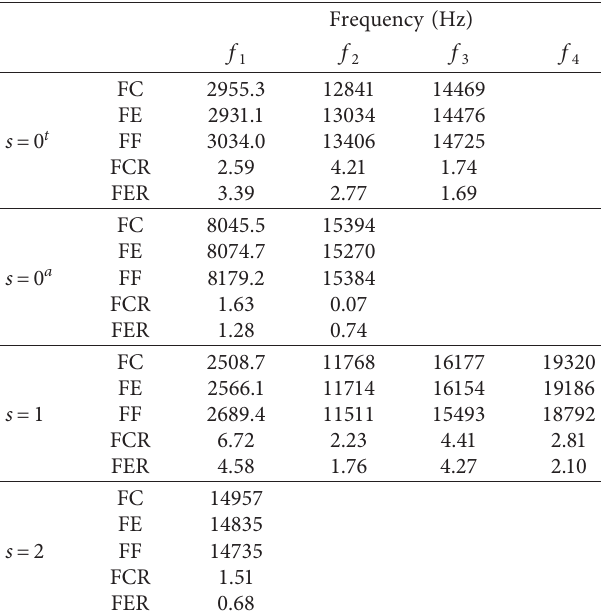
Table 4: Frequencies between 1kHz and 20kHz of HGS2 obtained by the Chebyshev–Ritz method and the experiment compared with those obtained by the finite element